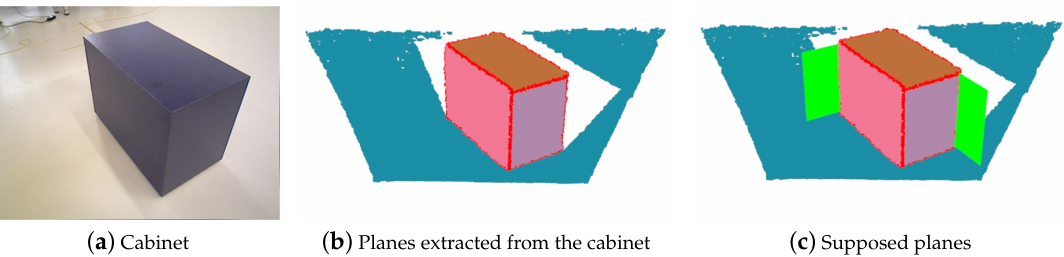
Figure 2. The process of generating supposed planes: ( a ) Cabinet. Aframe from sequence‘freiburg3_cabinet’ of TUM RGB-D dataset. There is only one cabinet in the image. ( b ) Planes extracted from the cabinet. Three planes of the cabinet are extracted. Different colors denote different planes. The red points are those belong to valid plane edges. ( c ) Supposed planes. The green planes denote supposed planes generated from plane edges. Other repeating supposed planes are